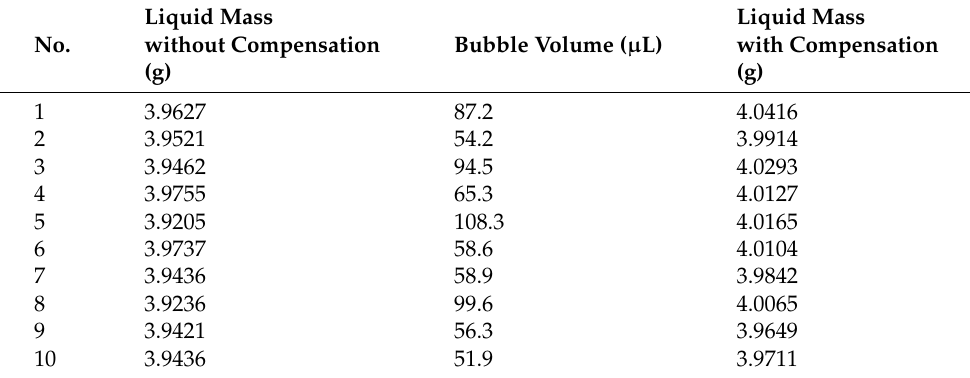
Table 3. Results of the sample-adding experiments using the bubble-detection method for compensa- tion (flow rate: 0.067